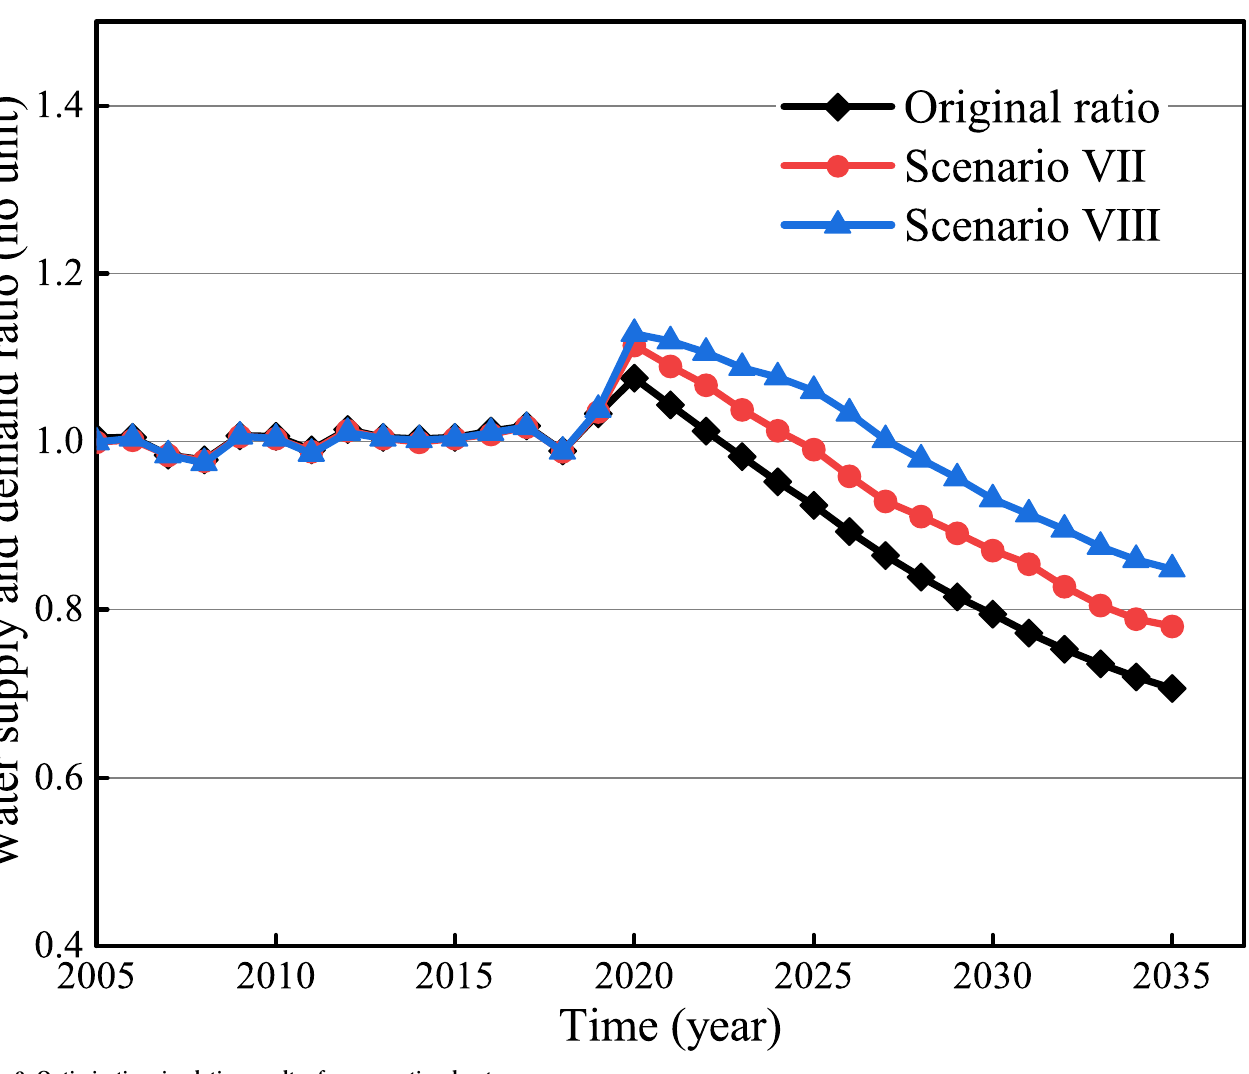
Fig 9. Optimization simulation results of unconventional water resources